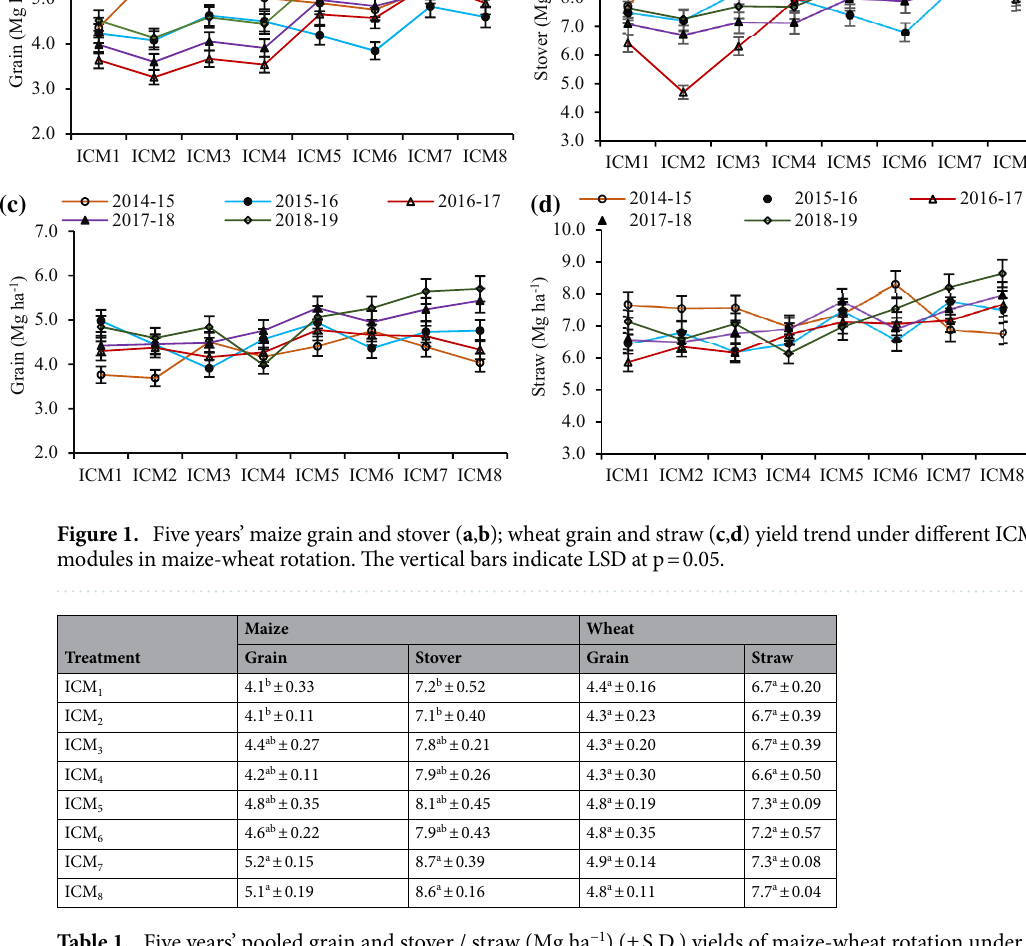
−1 ; L BFs = NPK liquid bio-